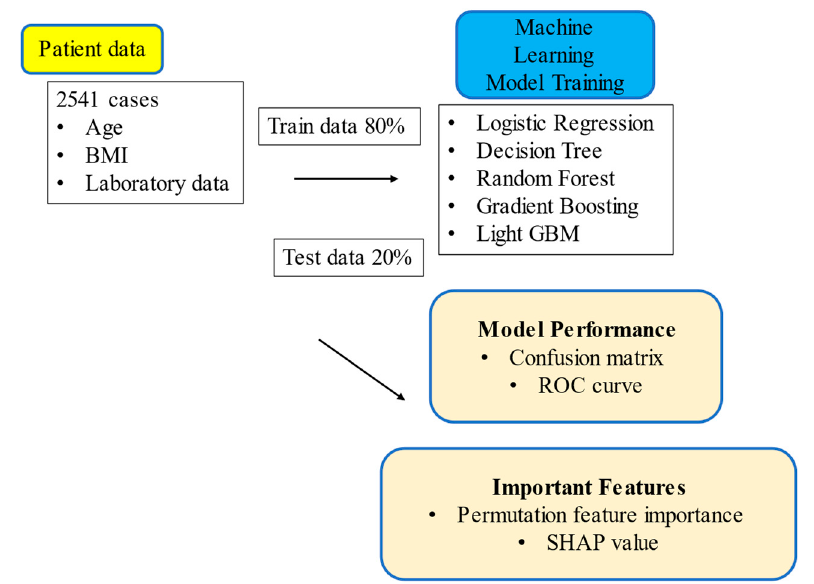
Figure 1. Workflow of data collection and machine learning. The data were divided into training data and test data, and five machine learning models were used. The trained models were evaluated using test data, and important features were visualized.